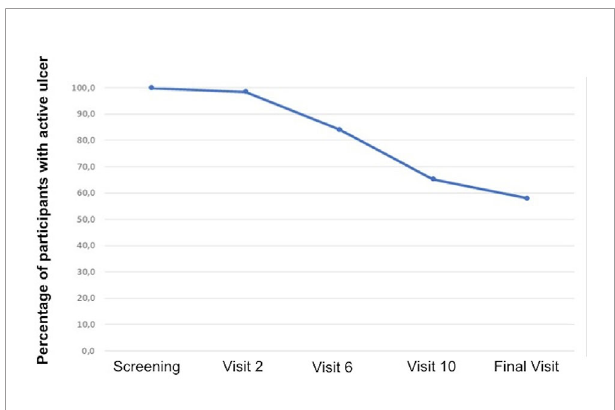
FIGURE 4 | Survival analysis in relation to